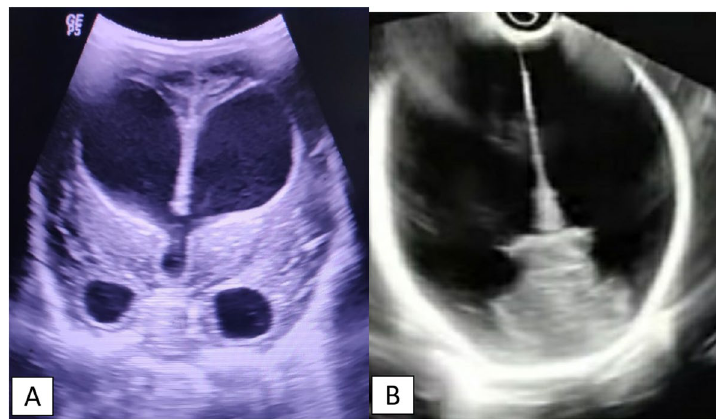
Fig. 4 CUS images in two different neonates showing congenital hydrocephalus ( A ) and hydranencephaly ( B